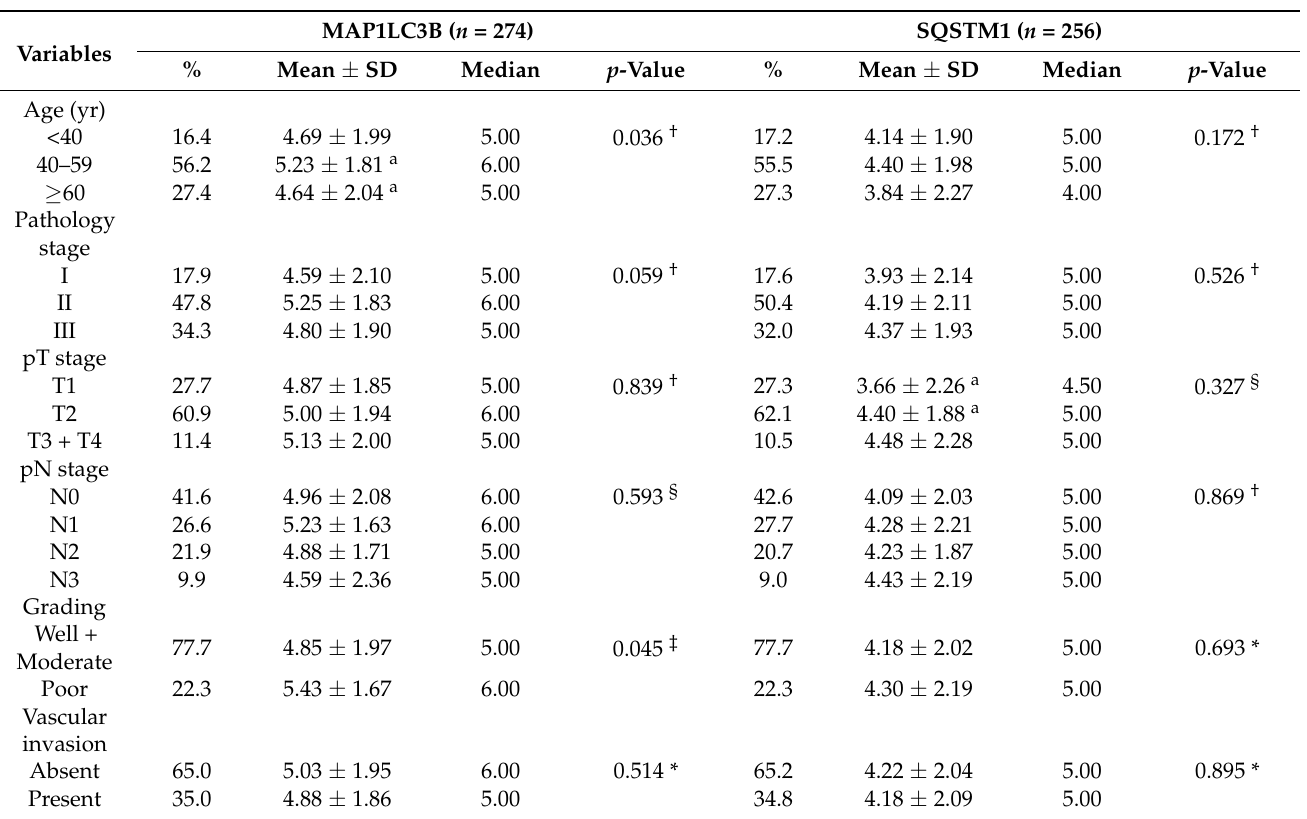
Table 2. Correlation of MAP1LC3B and SQSTM1expressions with clinicopathological outcomes in IDC